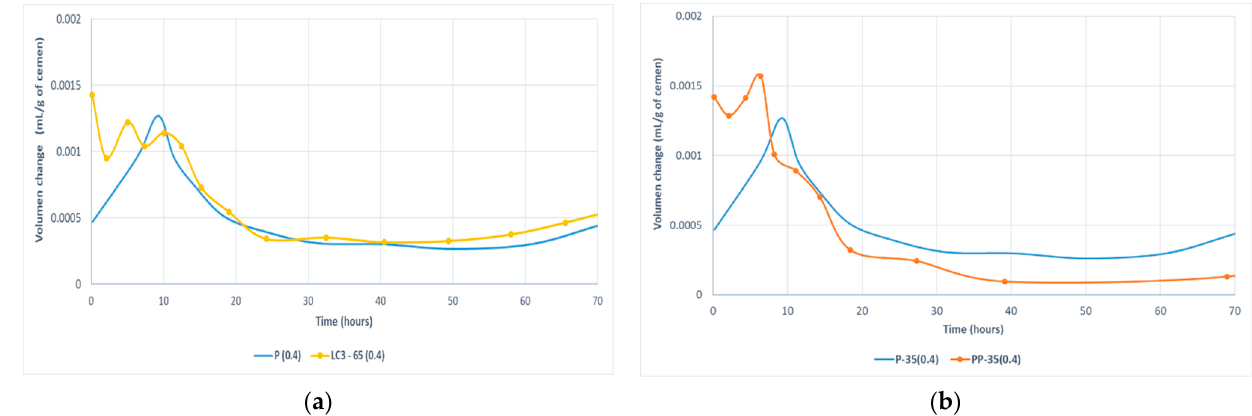
Figure 1. Effect of type of binder on volume changes in paste: ( a ) LC3 binder, ( b ) Pozzolanic cement containing 15% of natural pozzolan binder.